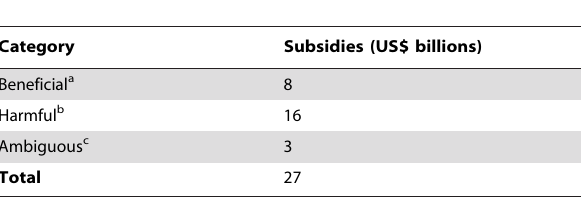
Table 4. Annual global fisheries subsidies by category